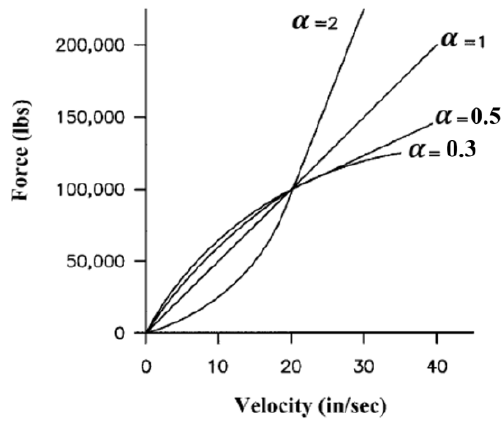
Figure 5. Plot of force against velocity for several values of the damping exponent modified from [42].